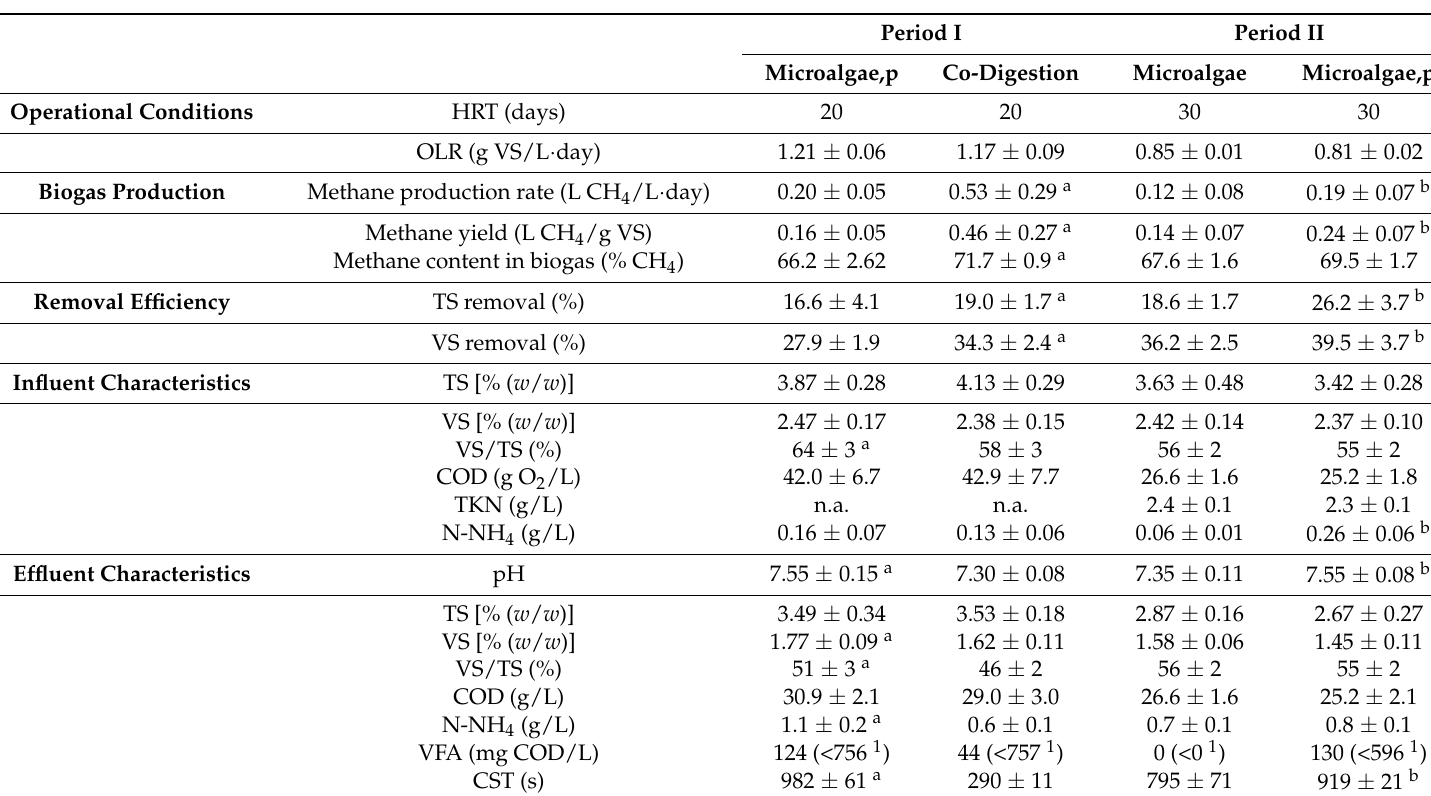
Table 3. Biogas production, solids removal, influent (substrate) and effluent (digestate) characteristics from untreated or thermally pretreated microalgae AD and co-digestion with primary sludge in lab-scale reactors. Mean ± standard deviation. OLR: organic loading